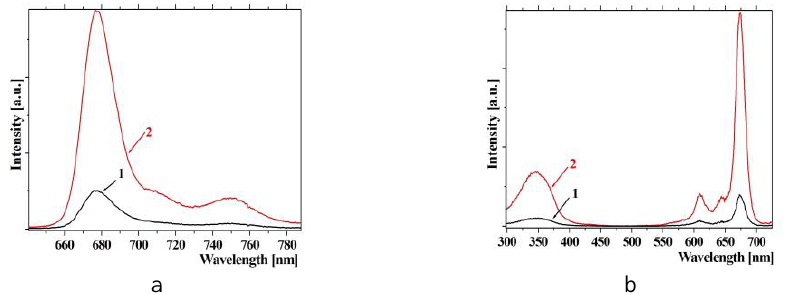
Fig. 2. Fluorescence spectra (a) at λ exc. = 350 nm and excitation of fluorescence (b) spectra at λ em. = 750 nm of Mg-Pc in binary mixture of Н 2 О-С 2 Н 6 OS (4:1): 1 - without AgNPs-SiO 2 ;2 - with AgNPs- SiO 2 at 293